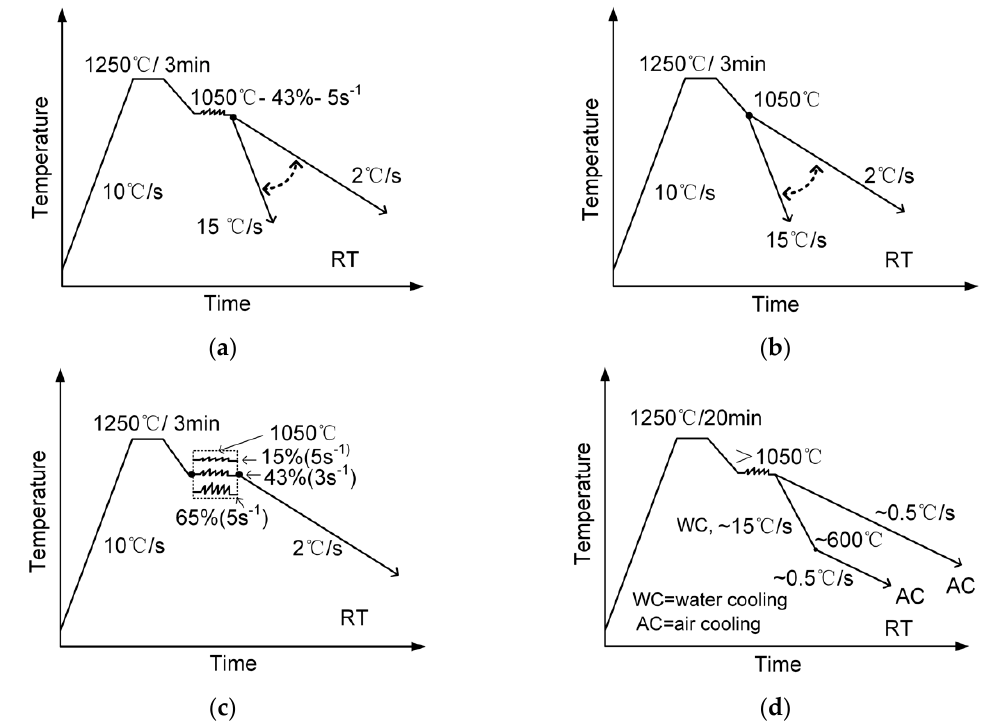
Figure 1. ( a – c ) Schematic diagrams of the thermomechanical simulation with different deformation and cooling processes; ( d ) processes of the hot rolling experiment.